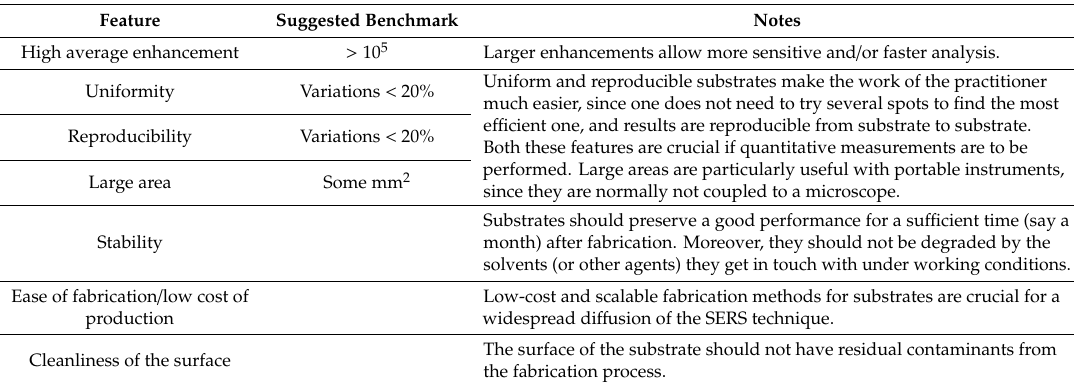
Table 6. Desired features of SERS substrates, proposed by Natan [85] and Lin et al.